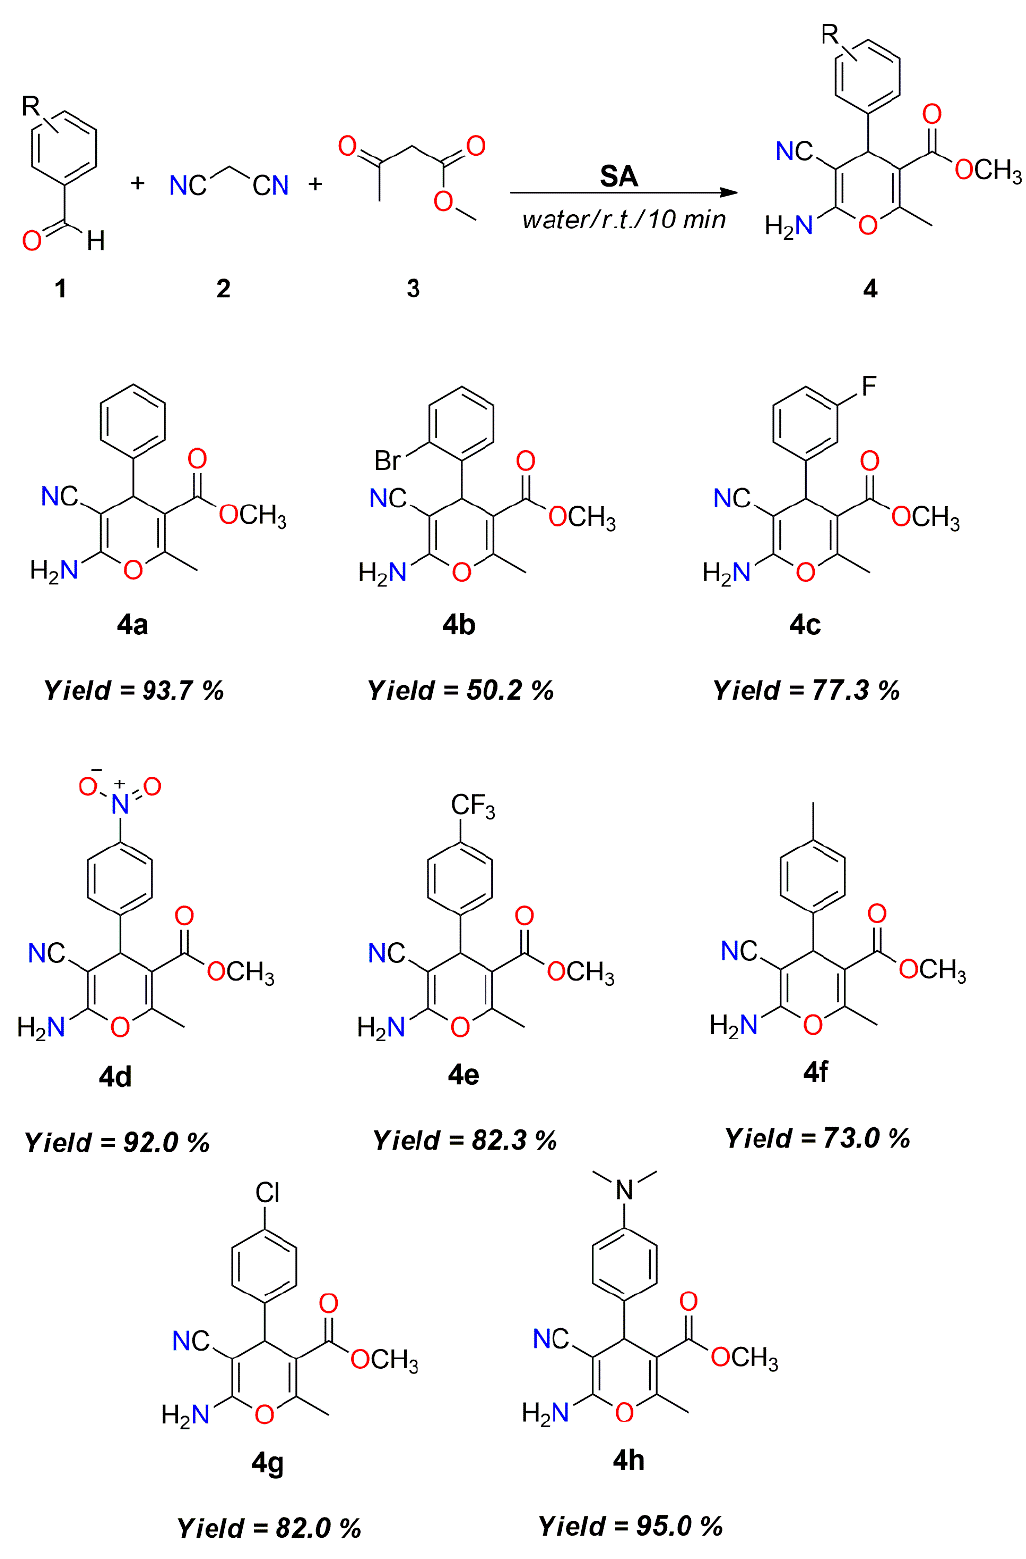
Figure 3. Synthesis of some 4 H -pyran derivatives ( 4a – f ) using the naturally occurring SA.